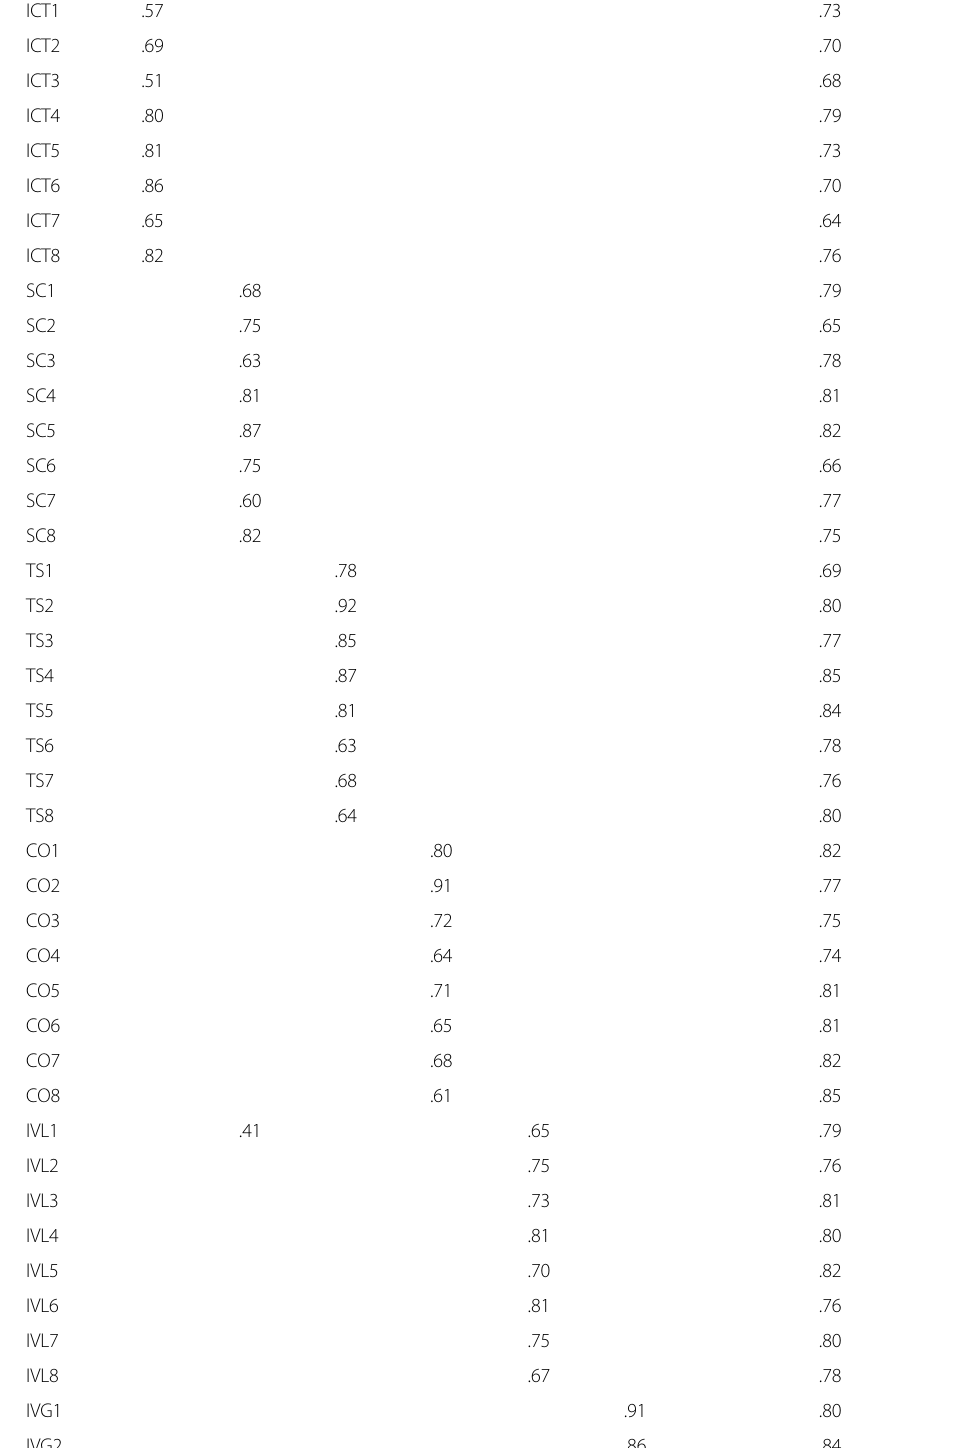
Table 6 Factor loadings and communalities for 55 items measuring ICT-supported learning environment perceptions ( N =